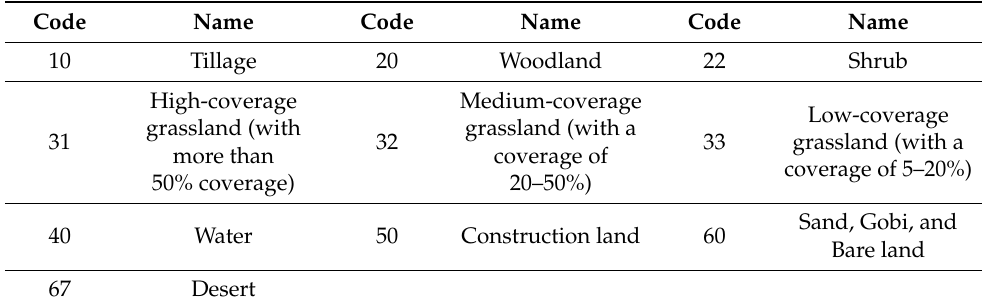
Table 1. Codes of land covers in the